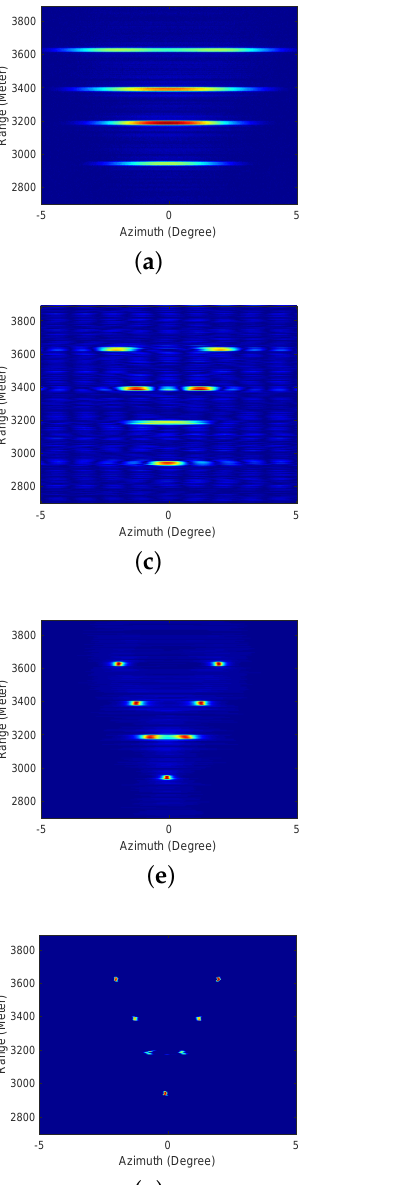
Figure 3. Original scene of the simulation.